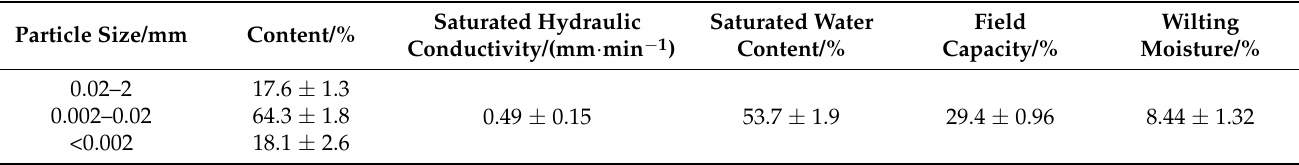
Table 5. Physical properties of experimental